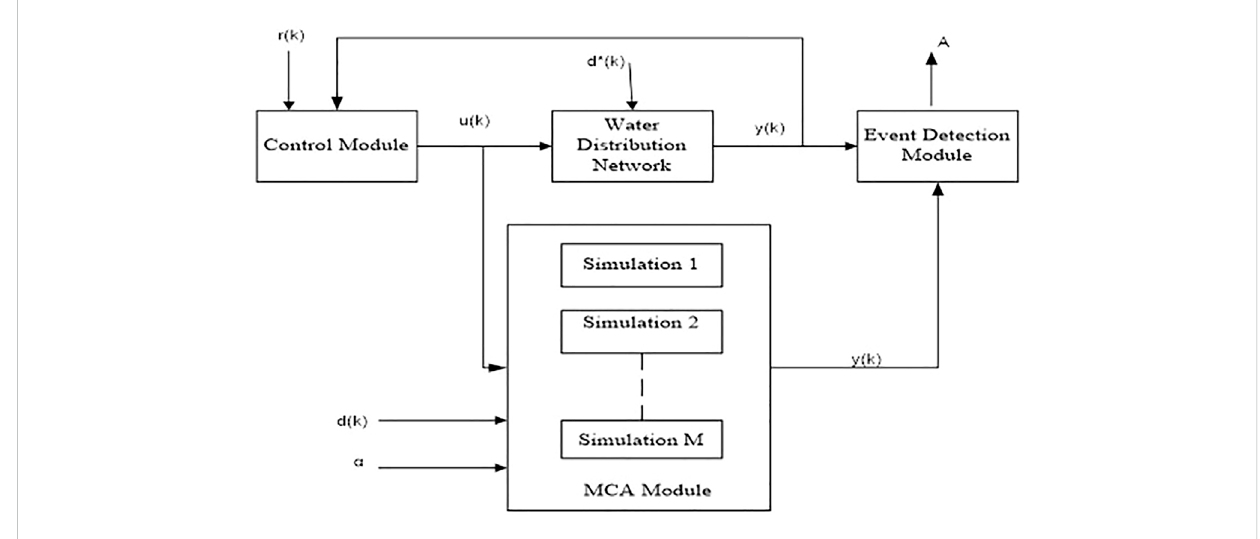
FIGURE 1 Architecture of the proposed